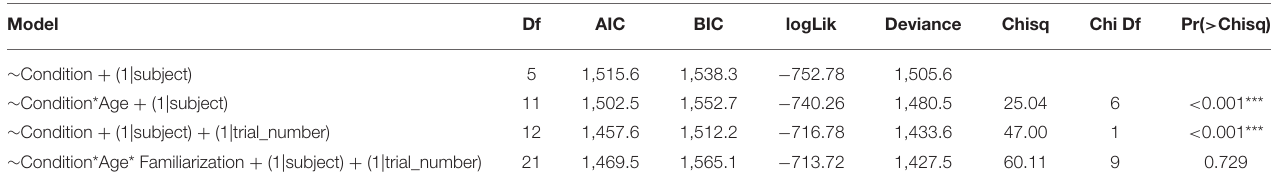
TABLE 4 | Results from the model comparison of the familiarization paradigm. Model Df AIC BIC logLik Deviance Chisq Chi Df Pr( > Chisq)